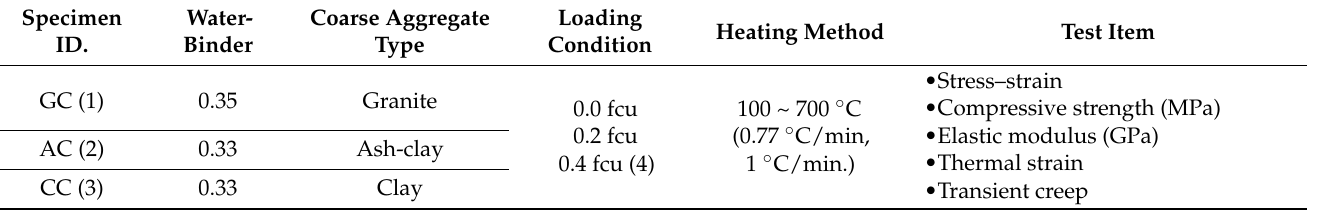
Table 3. Experimental